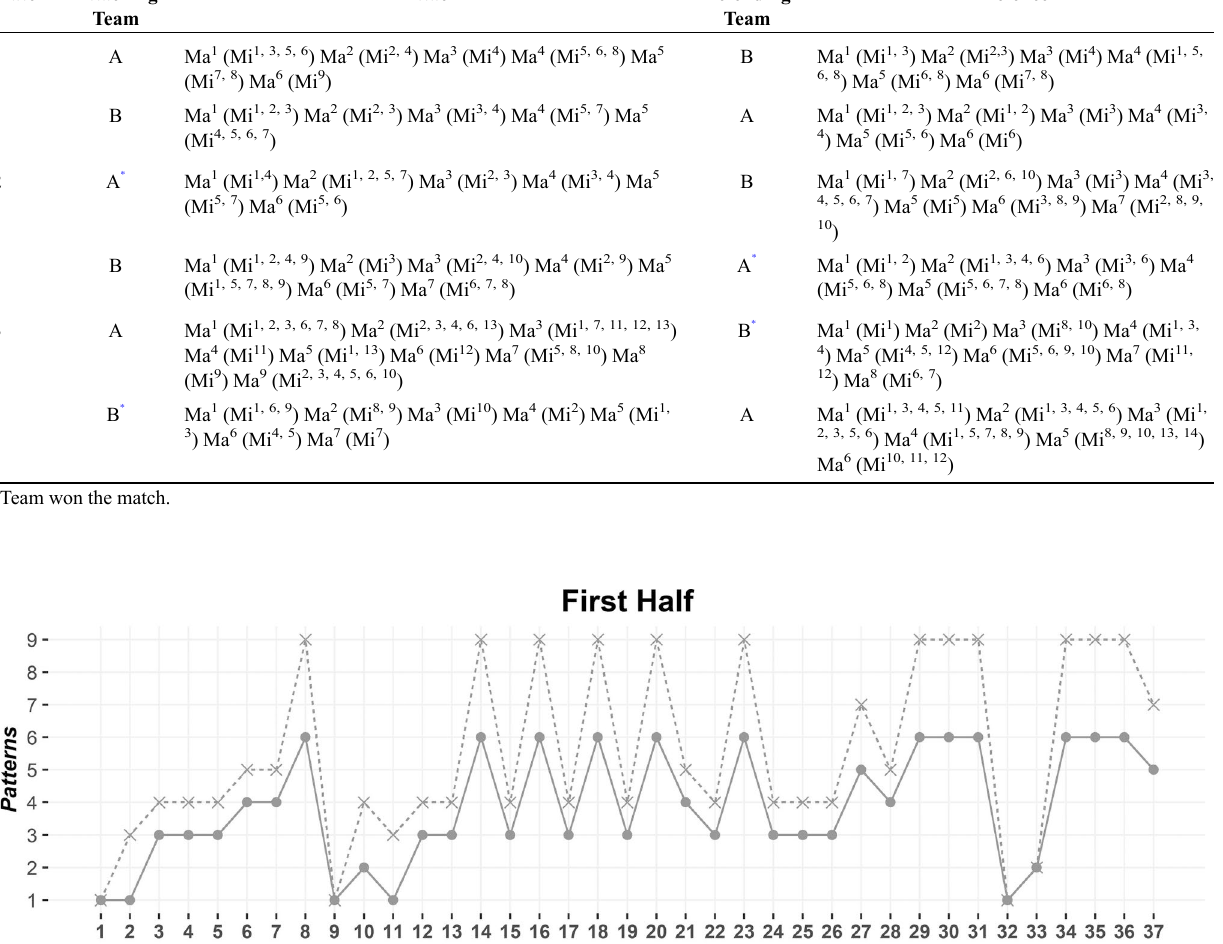
Table 1 - Teams' macrostructures (Ma) and microstructures (Mi) in attacks and defences in each match.